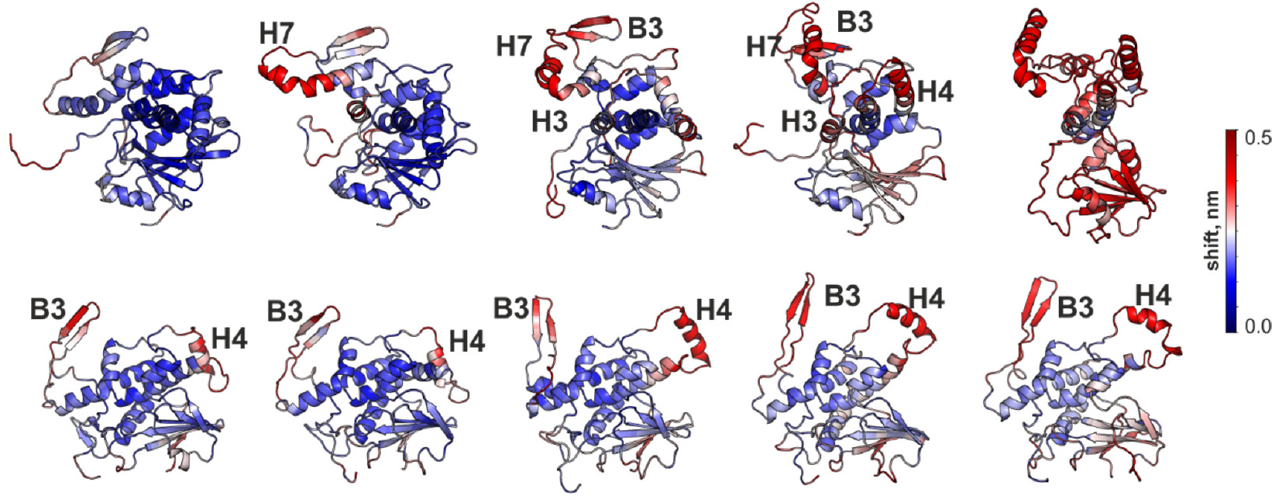
Figure 5. Evolution of the RTA (top row) and MLA (bottom row) structures during MD simulations in a chloroform/methanol mixture. Rows correspond to molecular events that occurred during the first five sequential 200-ns intervals of 10-µs MD runs. Other details are similar to those in Figure 4.